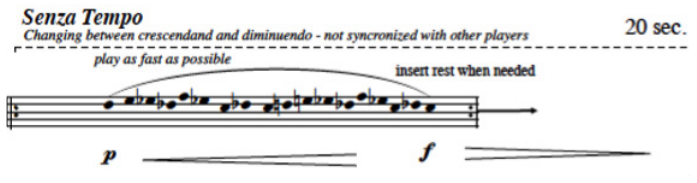
Figure 6. Senza Tempo with free tempo.